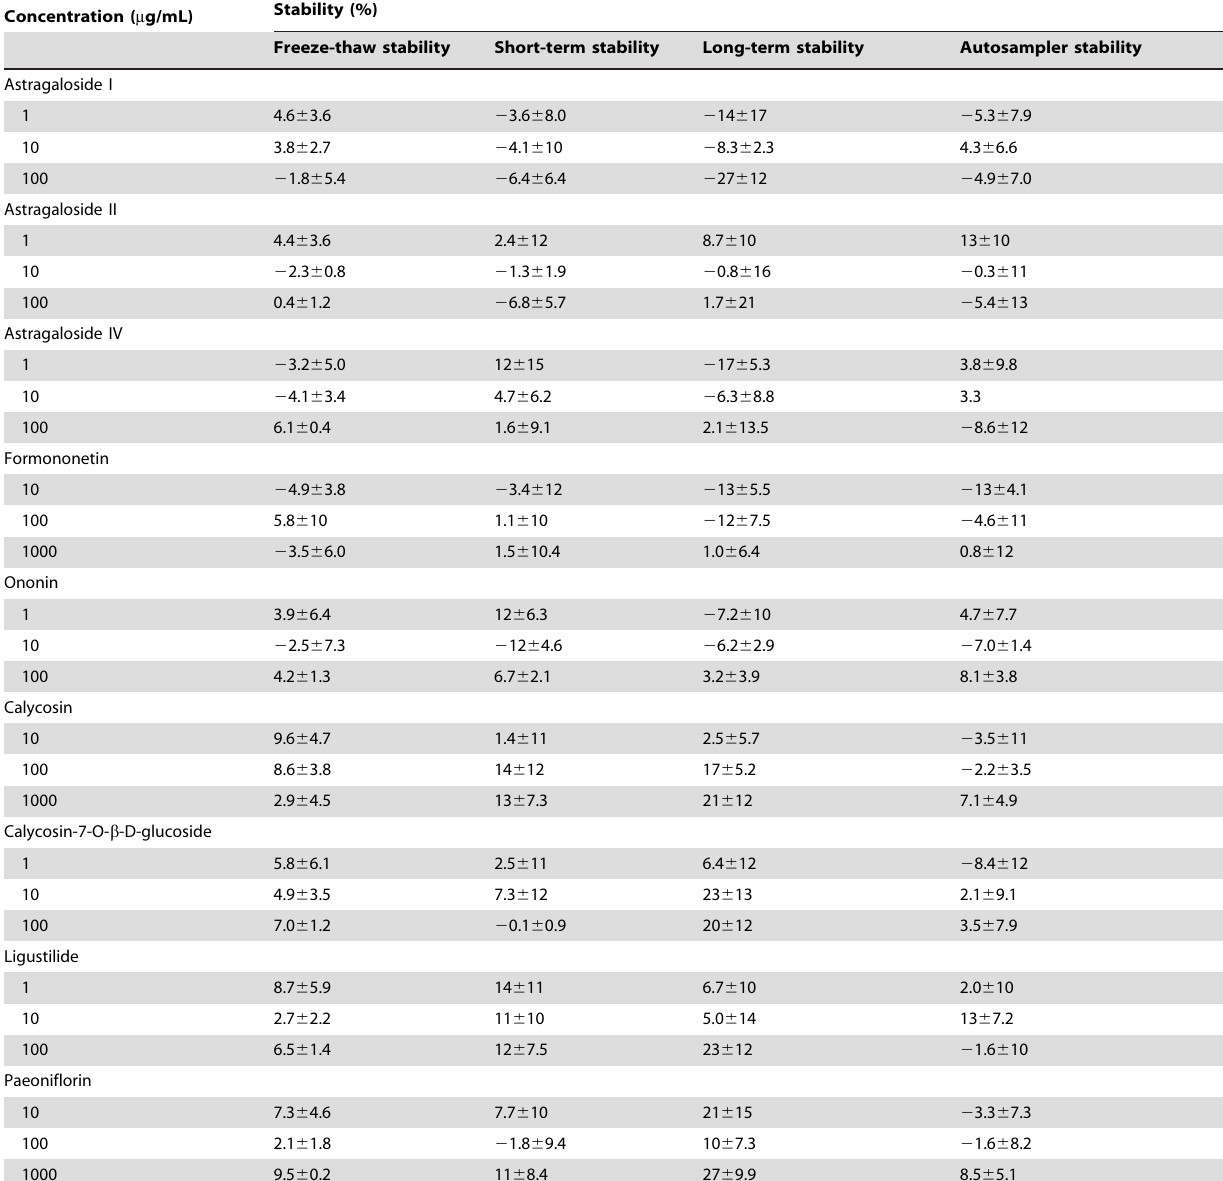
Table 4. Stability of the nine compounds in rat plasma